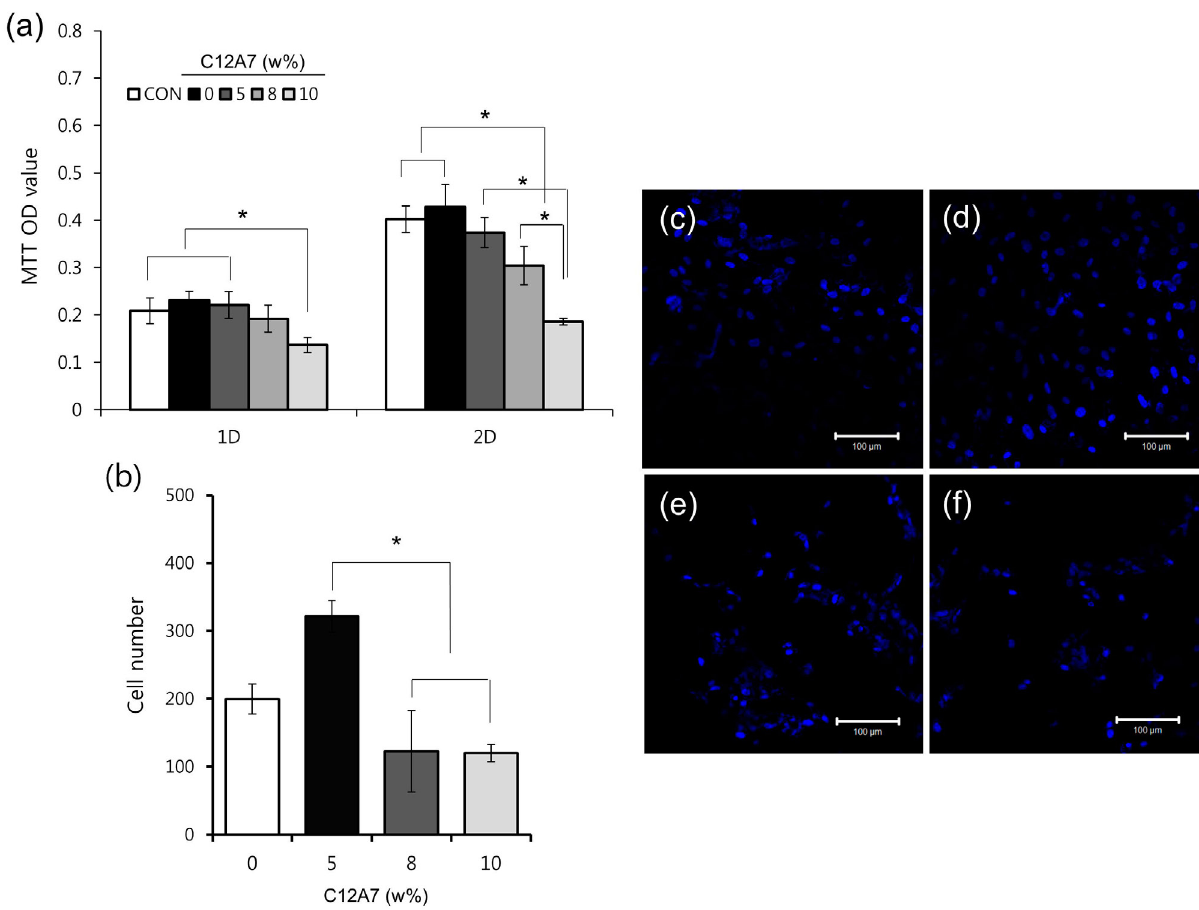
Figure 3- The cytocompatibility of C3S cement with the various proportions of C12A7; (A) The effects of C3S cement containing the various proportions of C12A7 on cell viability measured by the MTT assay; (B) The effects of C3S cement with the various proportions of C12A7 on the proliferation of hDPCs cultured on the specimens; (C-F) Representative confocal laser scanning microscopic images (x200) showing hDPCs (stained with DAPI) growing on the specimens (C12A7-0, 5, 8, and 10, respectively) after 48 h of culture. Statistical significance was determined at